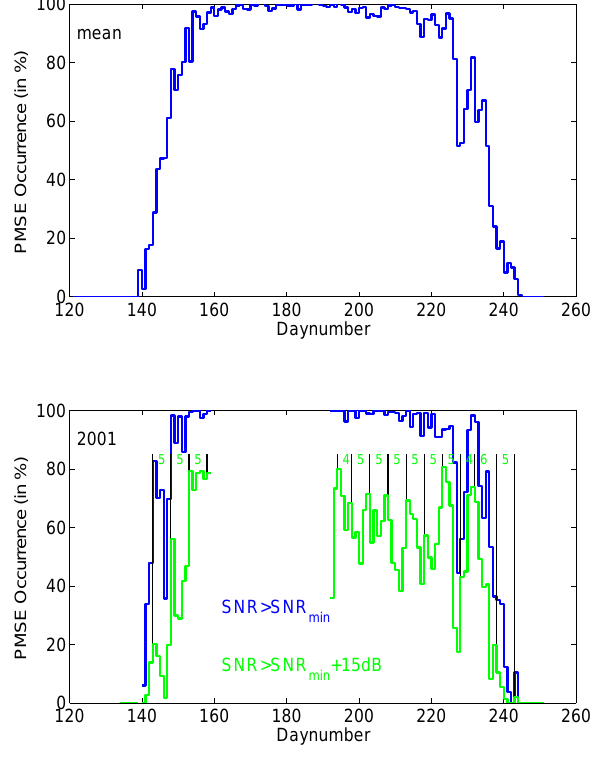
Fig. 3. Mean seasonal variations of daily total PMSE occurrence rates from SOUSY Svalbard Radar observations at Longyearbyen during five summers (upper panel) and the individual year 2001 (lower panel). The blue curve represents the development of the occurrence rate for all echoes with SNR > SNR min and the green curve for the strong echoes with SNR > SNR min +15dB. The thresh- old was assigned to SNR min =0dB in the year